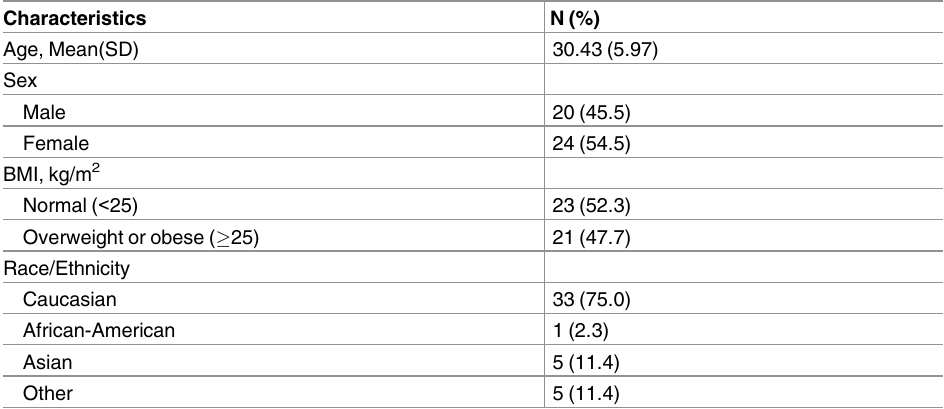
Table 1. Demographic characteristics of 44 participants.